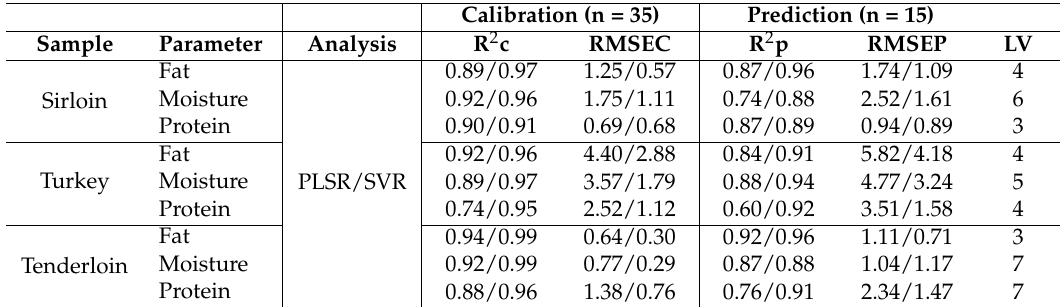
Table 3. Chemical component prediction in meat samples based on hyperspectral imaging (his) with SNV preprocessing